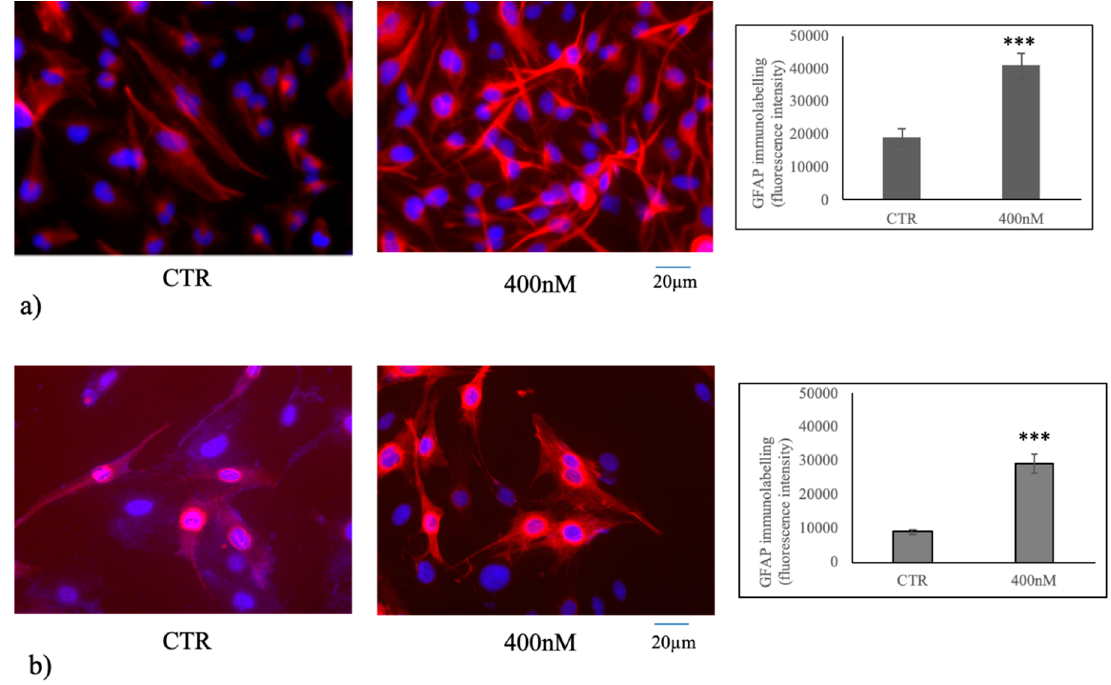
Figure 5. Immunofluorescence of U251 and LN18 cells without (CTR) or with 400 nM 1 α ,25(OH) 2 D 3 . The image represents the merged signal of glial fibrillary acidic protein (GFAP) immunolabelling, in red, counterstained with DAPI (in blue) in U251 cells ( a ) and LN18 cells ( b ). 20 × magnification. The fluorescent intensity measurement is on the right. Data were expressed as the mean ± S.D. of 3 independent experiments performed in duplicate. The significance value of 400 nM 1 α ,25(OH) 2 D 3 VD3 was calculated respect to the control sample. ∗∗∗ p < 0.001.